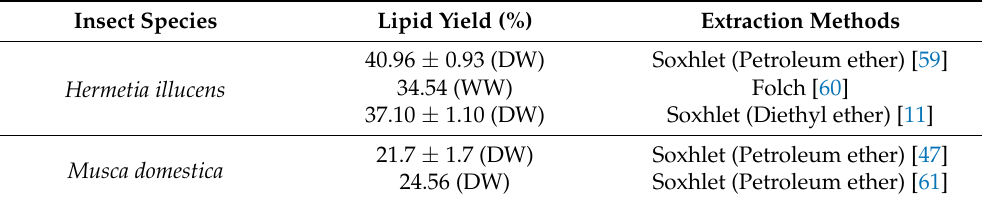
Table 2. Lipids yield and related extraction methods in the seven insect species admitted by European Regulations 893/2017 and 1372/2021. DW = dry weight, WW = wet